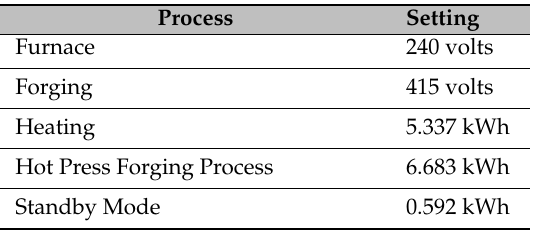
Table 3. Hot press forging settings and